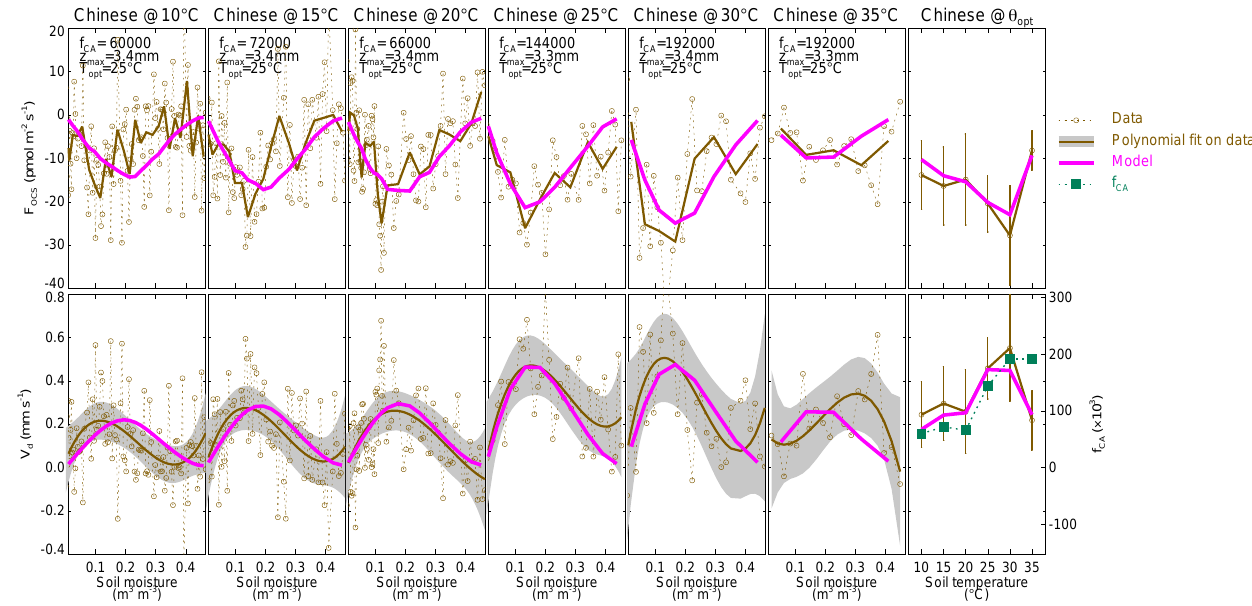
Figure 11. Same as Fig. 9 but for an agricultural soil from north-eastern China (soil weight is 80g).